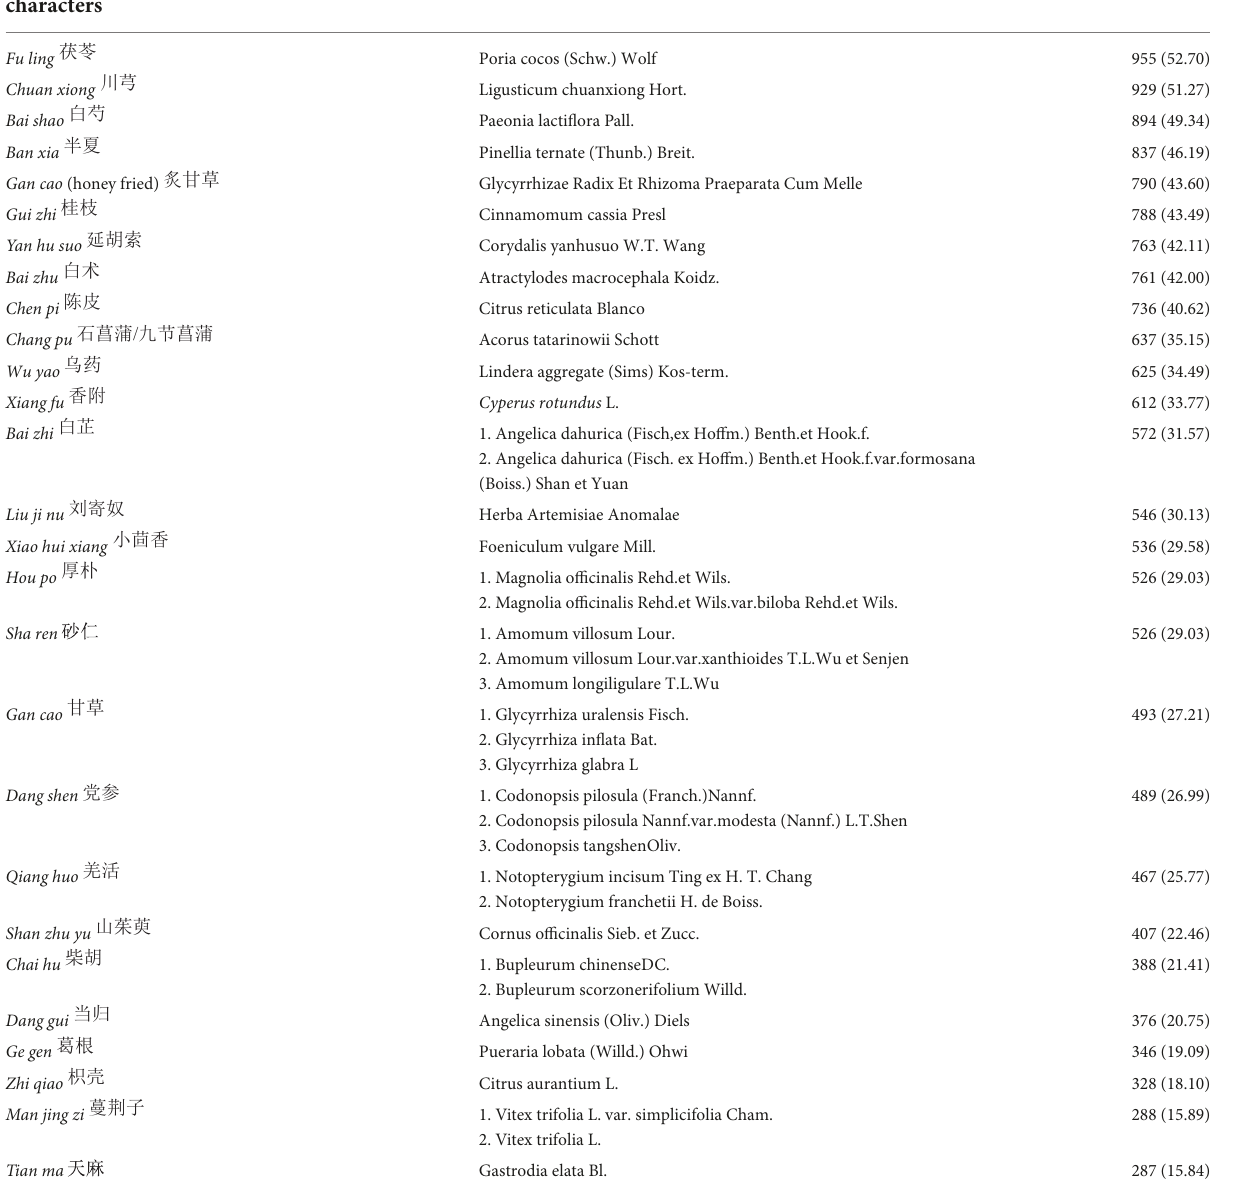
TABLE 4 Frequently used herbs in Chinese herbal decoctions for which patients reported